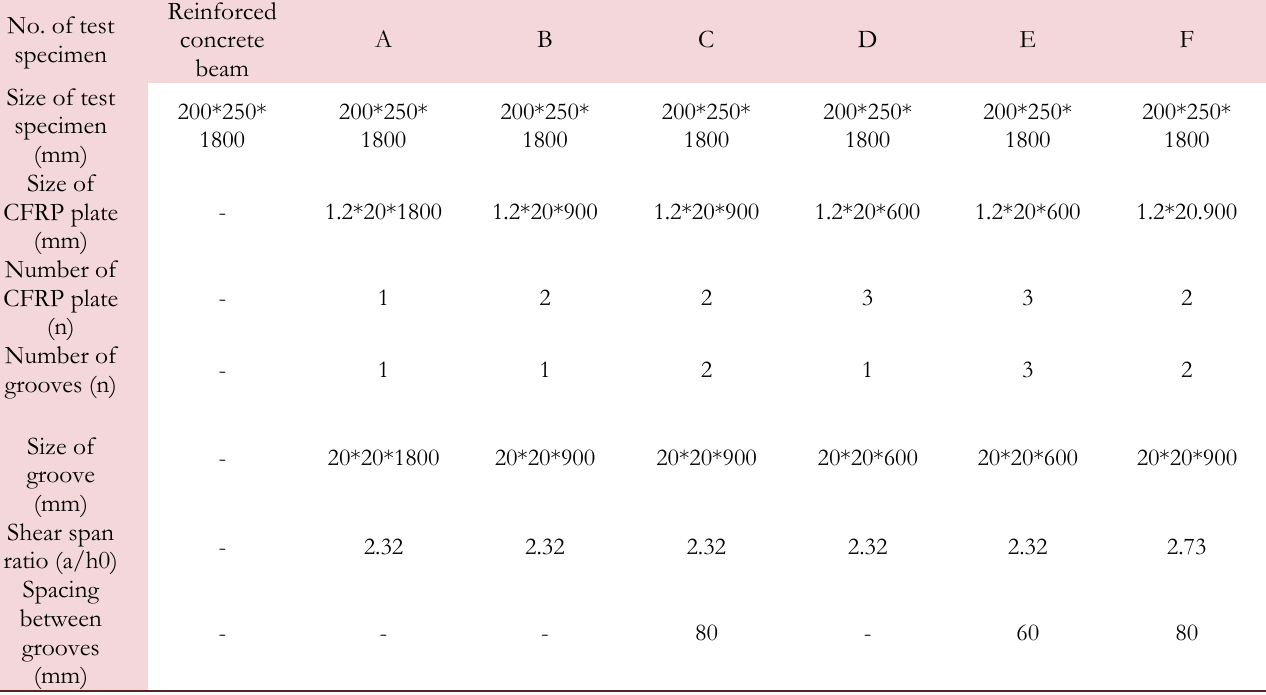
Table 4: The model